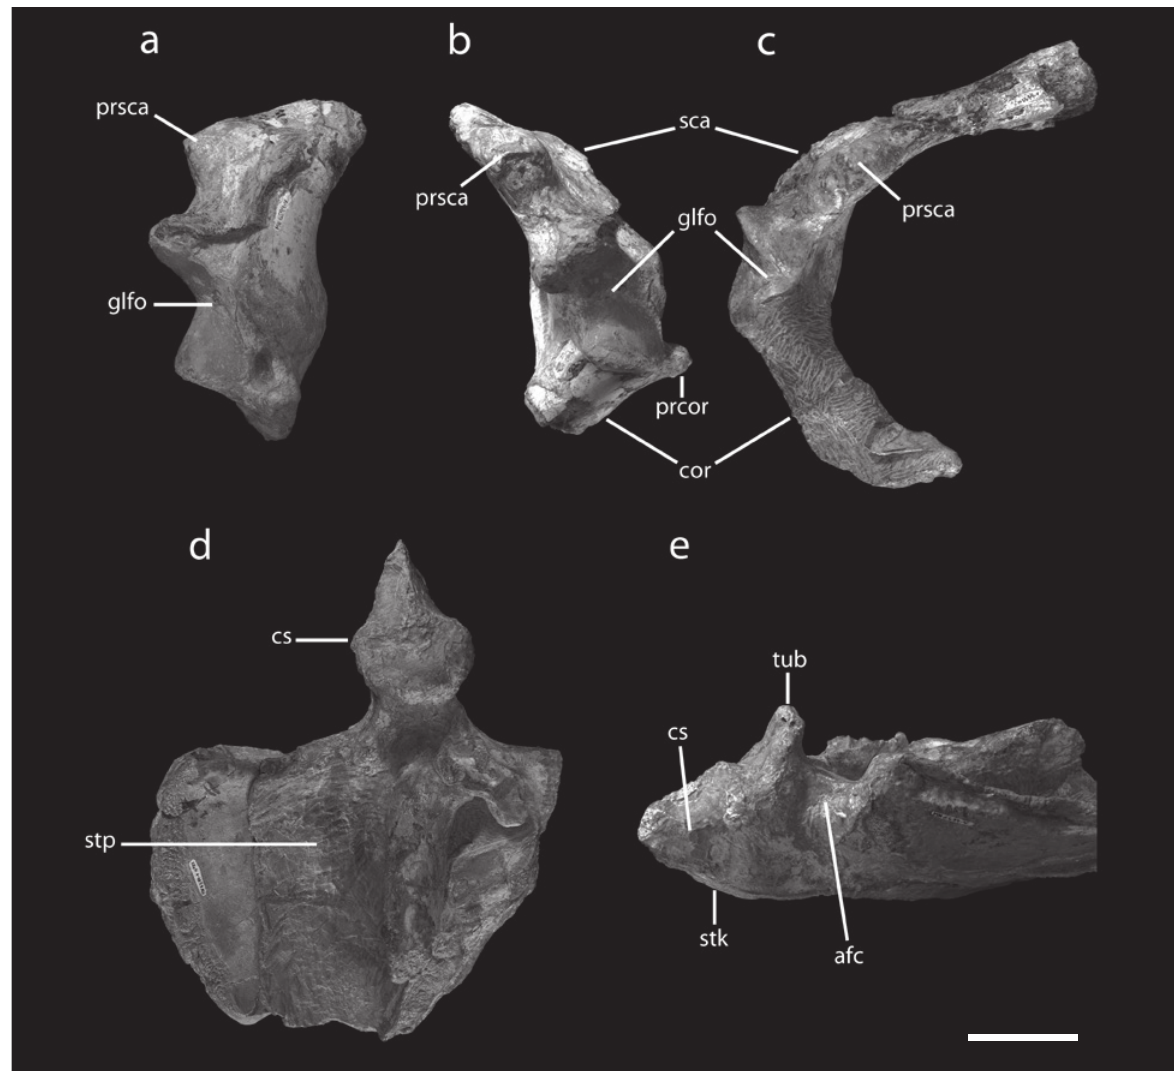
Fig. 6 - Postcranial elements of Tropeognathus cf. T. mesembrinus (MN 6594-V). (a) Right scapulocoracoid in anterior view. (b) Right scapulocoracoid in posterior view. (c) Left scapulocoracoid in posterior view. (d) Sternum in ventral view. (e) Anterior portion of the sternum in left lateral view. See text for abbreviations. Scale bar 50